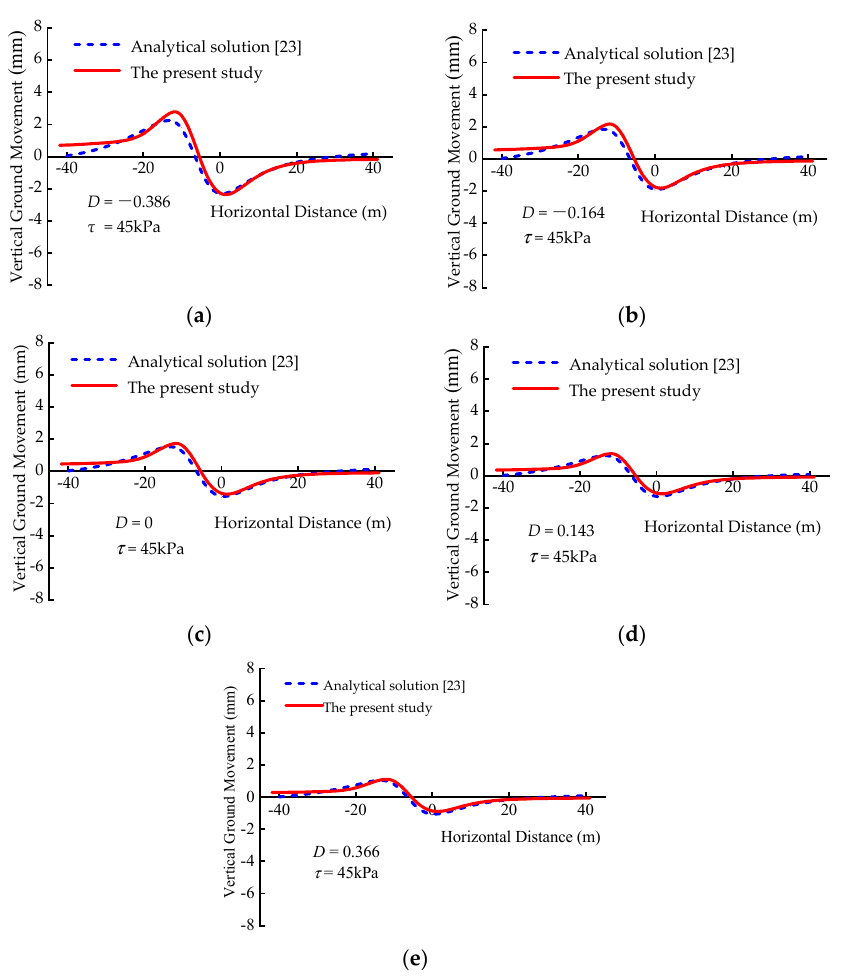
Figure 17. Vertical ground movements due to additional friction force at different disturbed states. ( a ) D = − 0.386; ( b ) D = − 0.164; ( c ) D = 0; ( d ) D = 0.143; ( e ) D = 0.366.